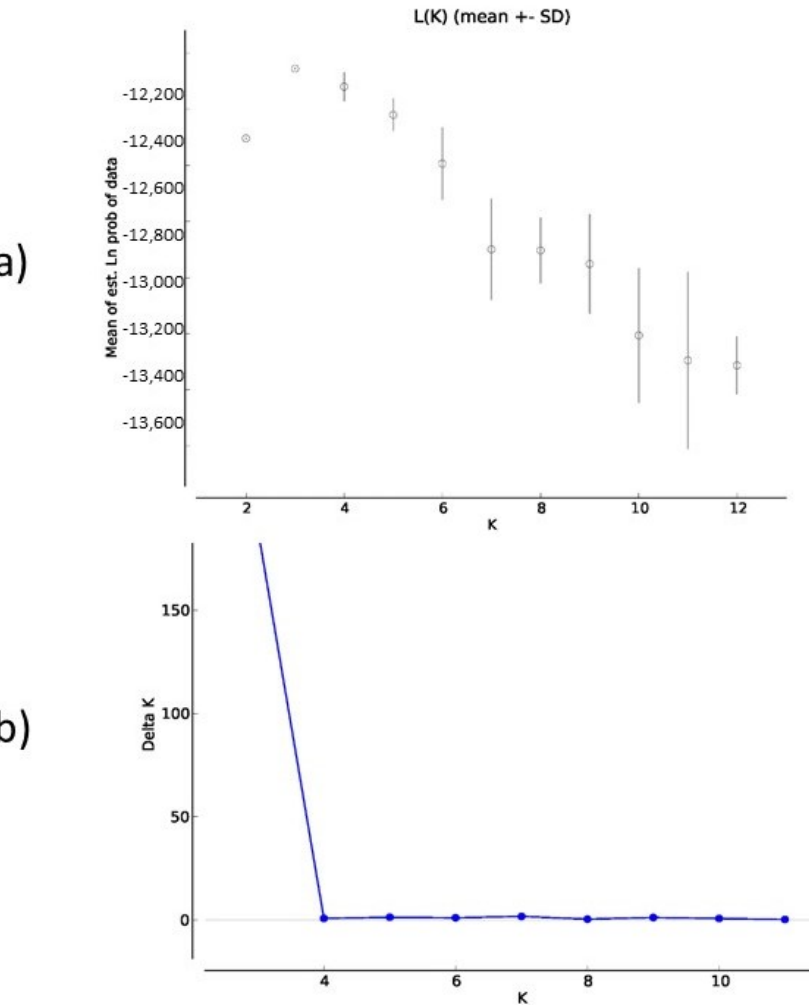
Figure 3. Delta K values of the STRUCTURE analysis of six Danubian horse sire lineages. ( a ) Delta K, calculated according to Evanno et al. [31], is plotted against the number of modeled gene pools (K). ( b ) The highest likelihood and Delta K were observed for K = 3.